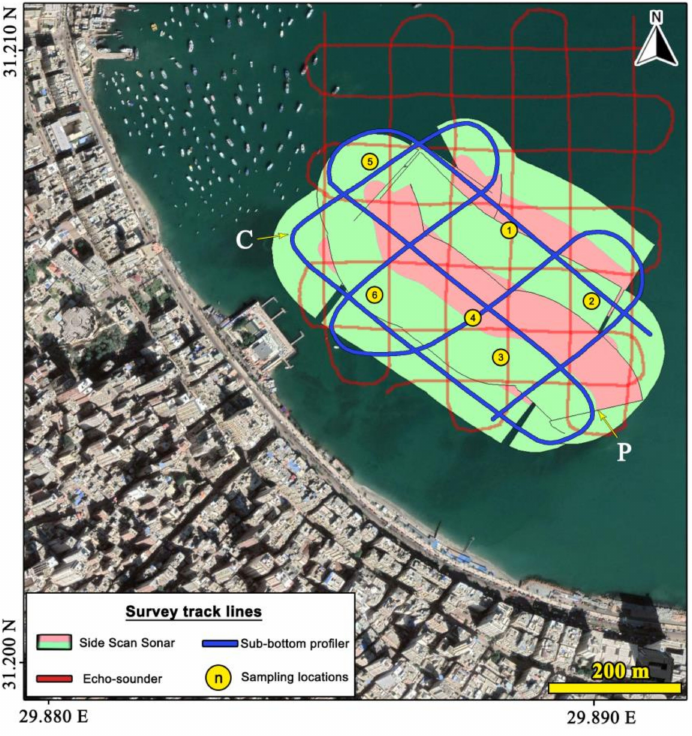
Figure 2. Map of the survey track lines in the study area. The bathymetric survey was run out using a dual-frequency echo-sounder (Teledyne Odom-Echotrac MK III), the transducer was pole-mounted to the port side of the survey vessel 0.5 m below the sea surface and provided 0.01 m resolution, survey grid